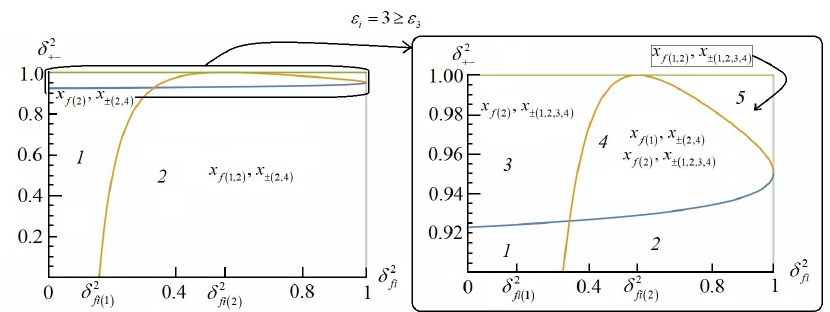
Figure 8. Regions in ( δ 2 , δ 2 + − ) –space with different possible values of particle energies. The energy fi of the initial electron is ε i = 3 ≥ ε 3 (see Conditions (41), (43), (45), (46)). The right picture shows the area of the left picture for δ 2 + − ∈ [ 0.9,1 ] . The blue line shows the dependence of the first characteristic (cid:16) (cid:17) δ 2 opening angle of the pair δ 2 , ε i = 3 on the outgoing angle of the scattered electron at the + − ( 1 ) fi energy of the initial electron ε i = 3. The orange line shows the dependence of the second characteristic (cid:16) (cid:17) δ 2 opening angle of the pair δ 2 , ε i = 3 on the outgoing angle of the scattered electron at the + − ( 2 ) fi energy of the initial electron ε i = 3.